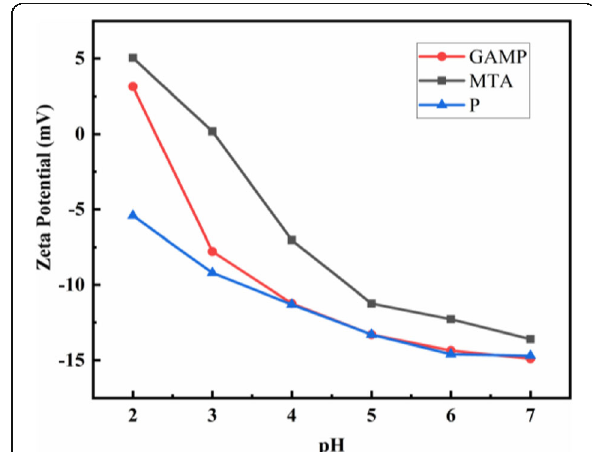
Fig. 5 Zeta potentials of the P, GAMP and MTA